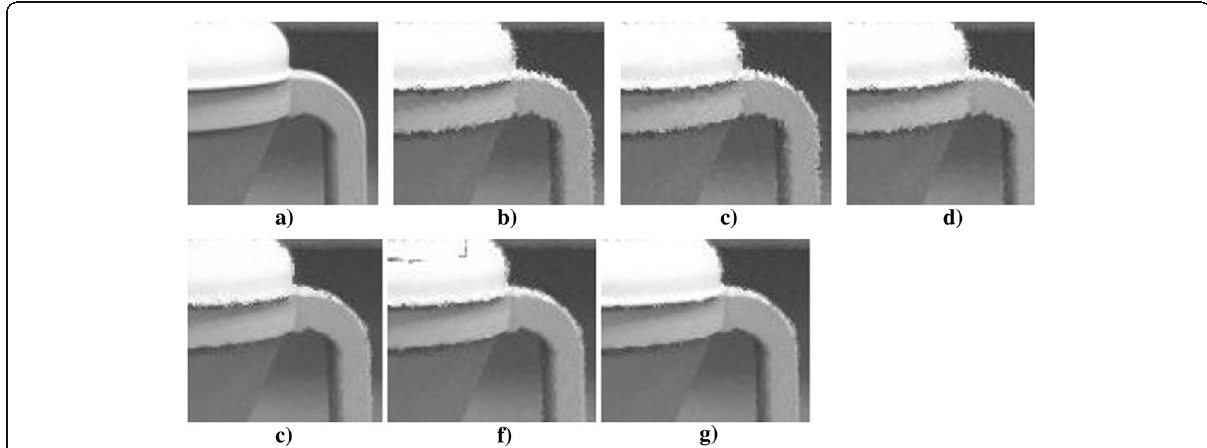
Fig. 8 Zoomed results with 50% impulsive noise. a Original image. b AMF. c AWMF. d Bhateja [20]. e SAMF. f Bhadouria [21]. g Proposed ADWMF